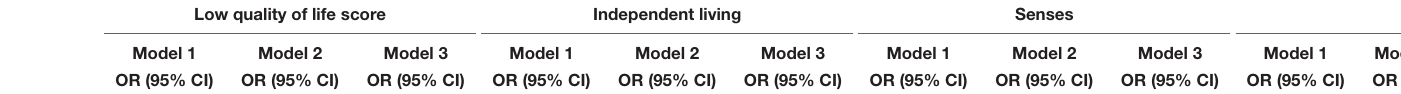
TABLE 2 | Multiple logistic regression analysis of the association of ARHL severity with high quality of life (low score) and low subscores in domain-specific quality of life.